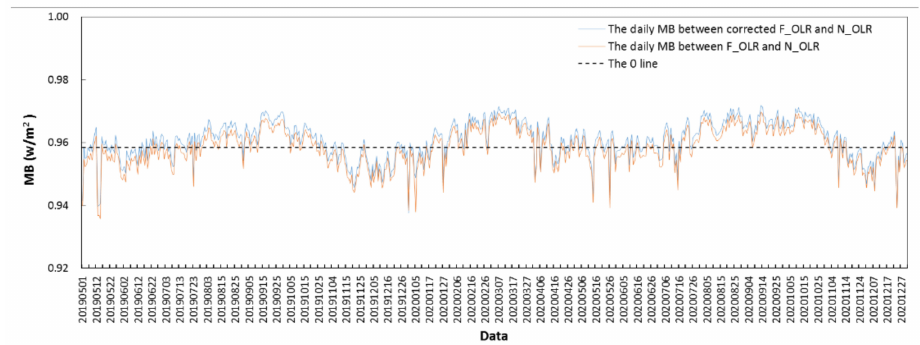
Figure 6. Variations in the correlation coefficient (R) between the uncorrected F _OLR and N _OLR and between the corrected F _OLR and N _OLR